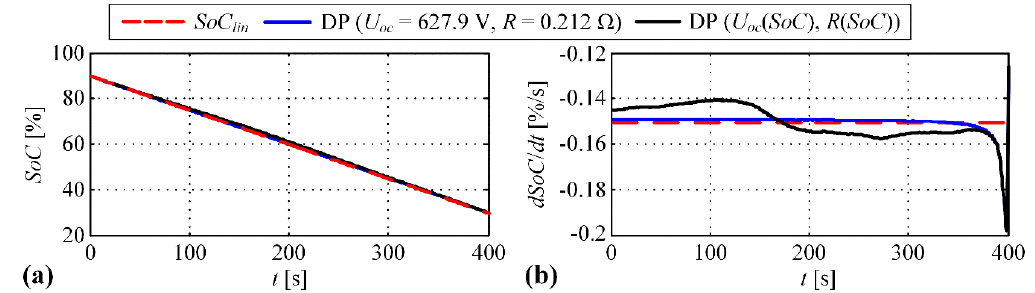
Figure 8. SoC trajectories obtained by constant SoC depletion rate ( SoC lin ) and by DP optimization for the constant and variable SoC-dependent battery parameters ( a ), and corresponding SoC depletion rates ( b ).